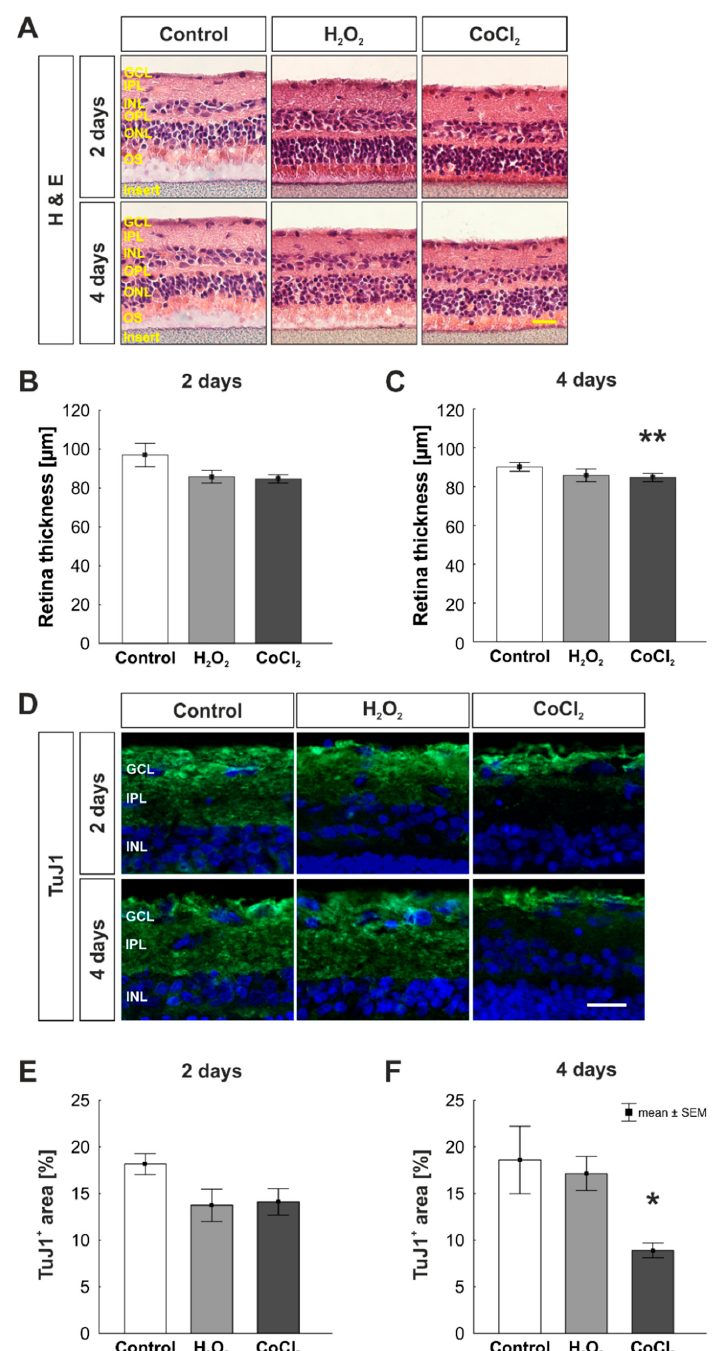
Figure 3. Reduced retinal thickness through hypoxic stress. ( A ) Exemplary images of H & E-stained retinas at two and four days. ( B ) No alteration regarding the retinal thickness was noted within the groups at two days. ( C ) At four days, significantly thinner retinas were observed in the hypoxia- stressed group ( p = 0.006). ( D ) Representative images of TuJ1 (green) stained cross-sections. DAPI was used to visualize cell nuclei (blue). ( E ) Area measurements of immunopositive area revealed no alteration within the groups at two days. ( F ) At four days, a significant reduction of TuJ1 + area in CoCl 2 -stressed retinas was noted ( p = 0.029). GCL = ganglion cell layer; IPL = inner plexiform layer; INL = inner nuclear layer; OPL = outer plexiform layer; ONL = outer nuclear layer; OS = outer segments. ( B , C ): n = 8; ( E , F ): n = 6. Scale bars: 20 µ m. Values are shown as mean ± SEM. Columns marked with * show significant differences in comparison to the control group. * p < 0.05; ** p <